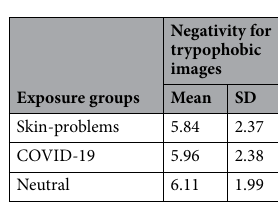
Table 2. Negativity of trypophobic images in each exposures